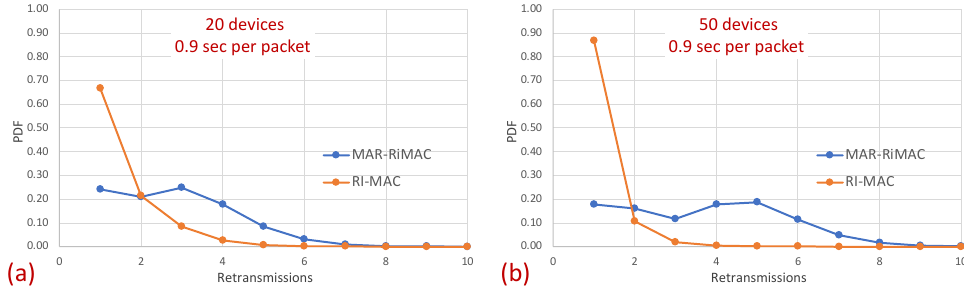
Figure 13. Hidden-terminal topology: The probability density distribution (PDF) of the number of retransmissions in RI-MAC. ( a ) Twenty devices. ( b ) Fifty